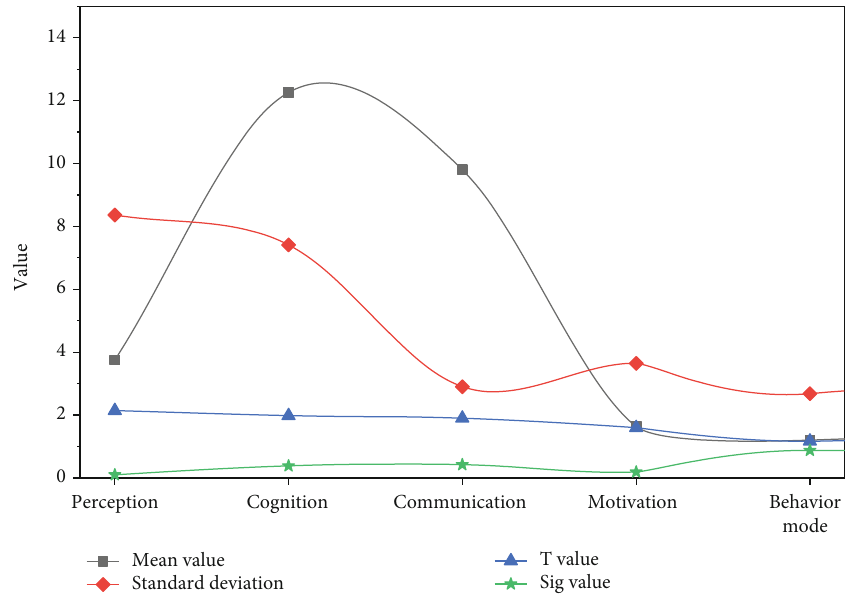
Figure 7: Comparison of the di ff erence of SRS scale before and after test in the control